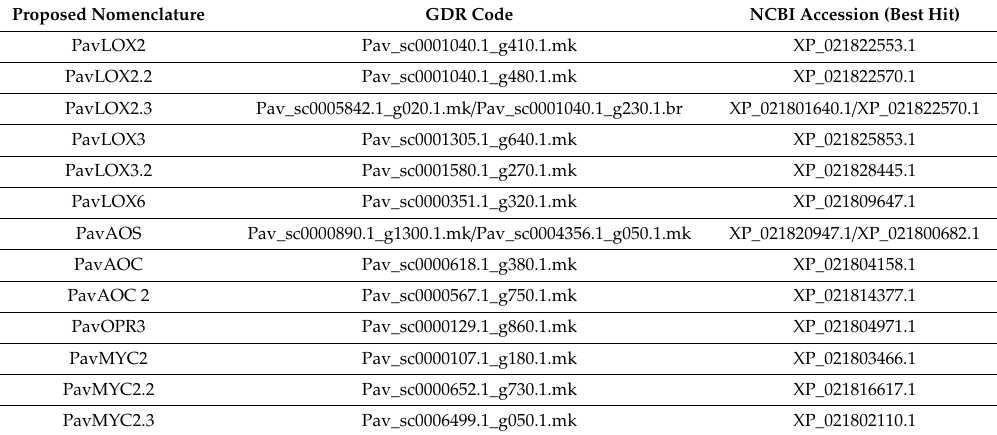
Table 1. Details of the identified JA biosynthetic genes ( 13-LOX , AOS , AOC , OPR3 , MYC2 ) in P. avium , with proposed nomenclature, GDR (Genomic Database for Rosaceae ) codes and NCBI accession numbers. Genes separated by / indicate